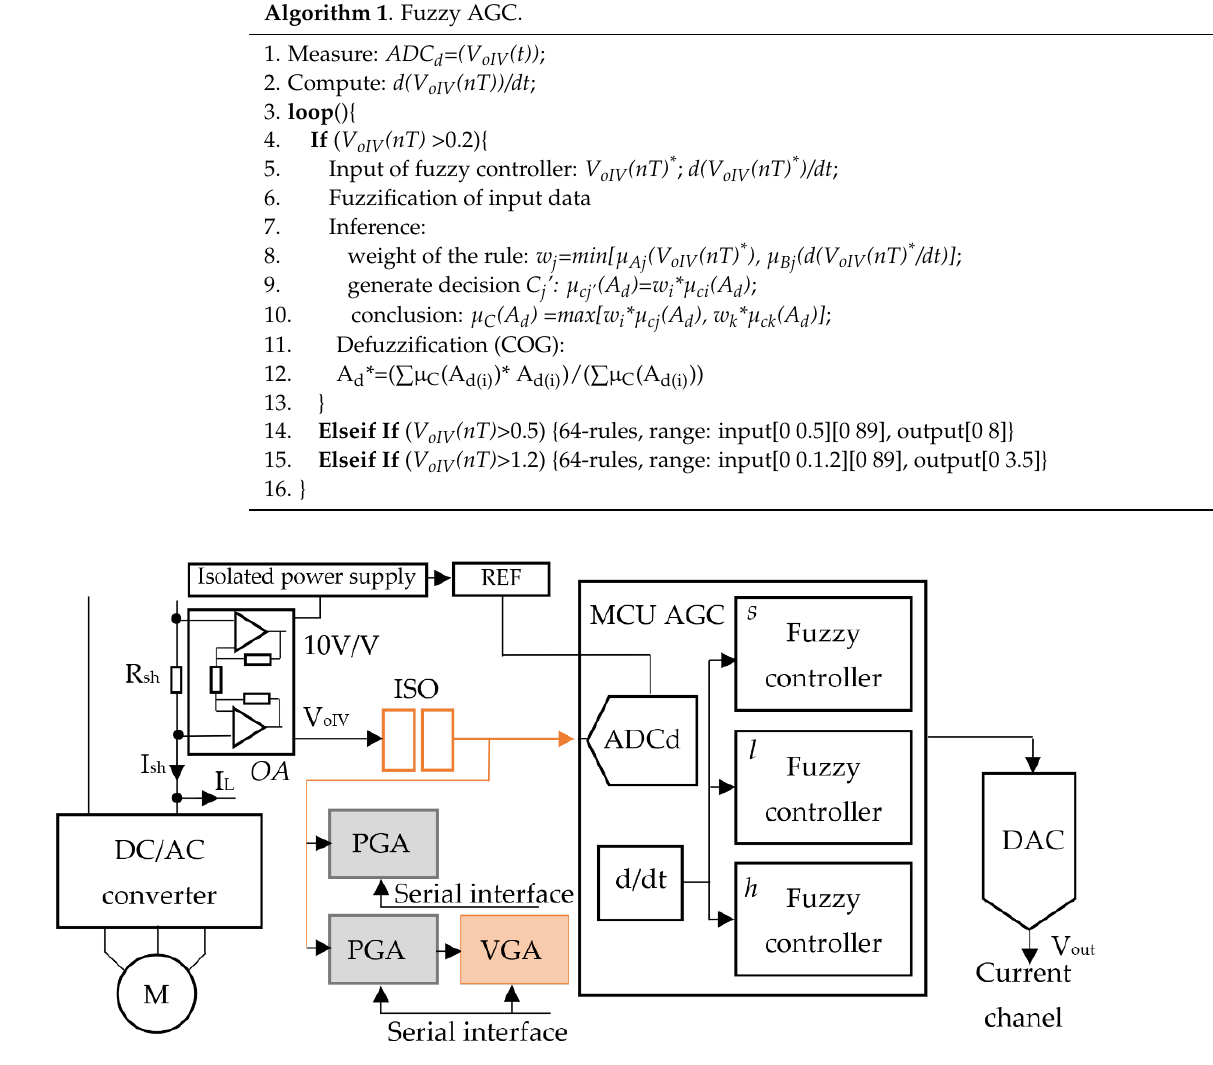
Figure 4. Structure AGC of the fuzzy controller in the current measurement.